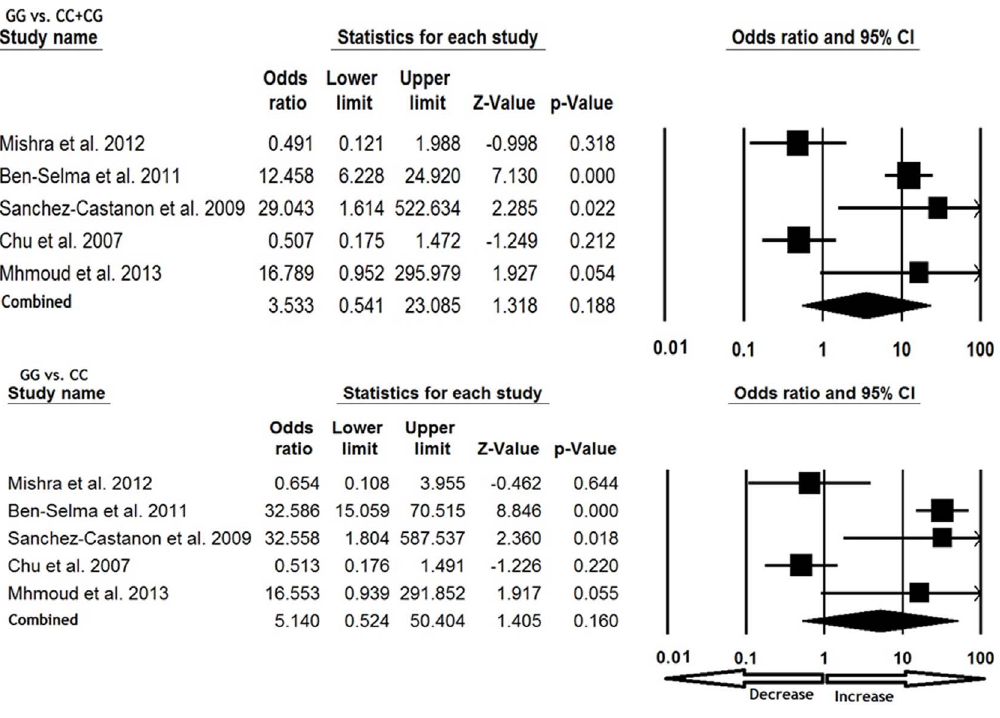
Figure 2. Forest plot analysis for assessing the association between TB risk and CCL5 28 C . G polymorphism. (Note: Analysis of GG vs. CC + CG and GG vs. CC, studies of Selvaraj et al., [12] is not included due to lack of GG genotype in both the TB cases and controls)